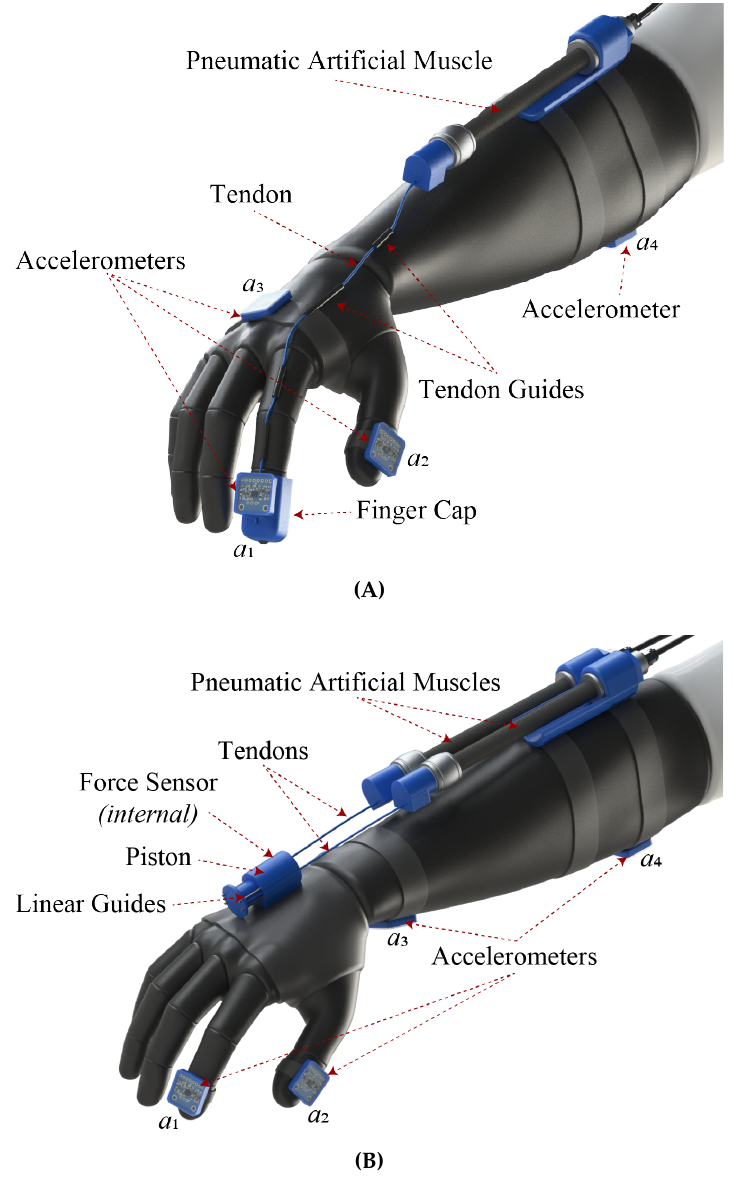
Figure 2. The exoskeletal glove concept for investigating tremor suppression via force application on the ( A ) index finger and ( B ) metacarpal